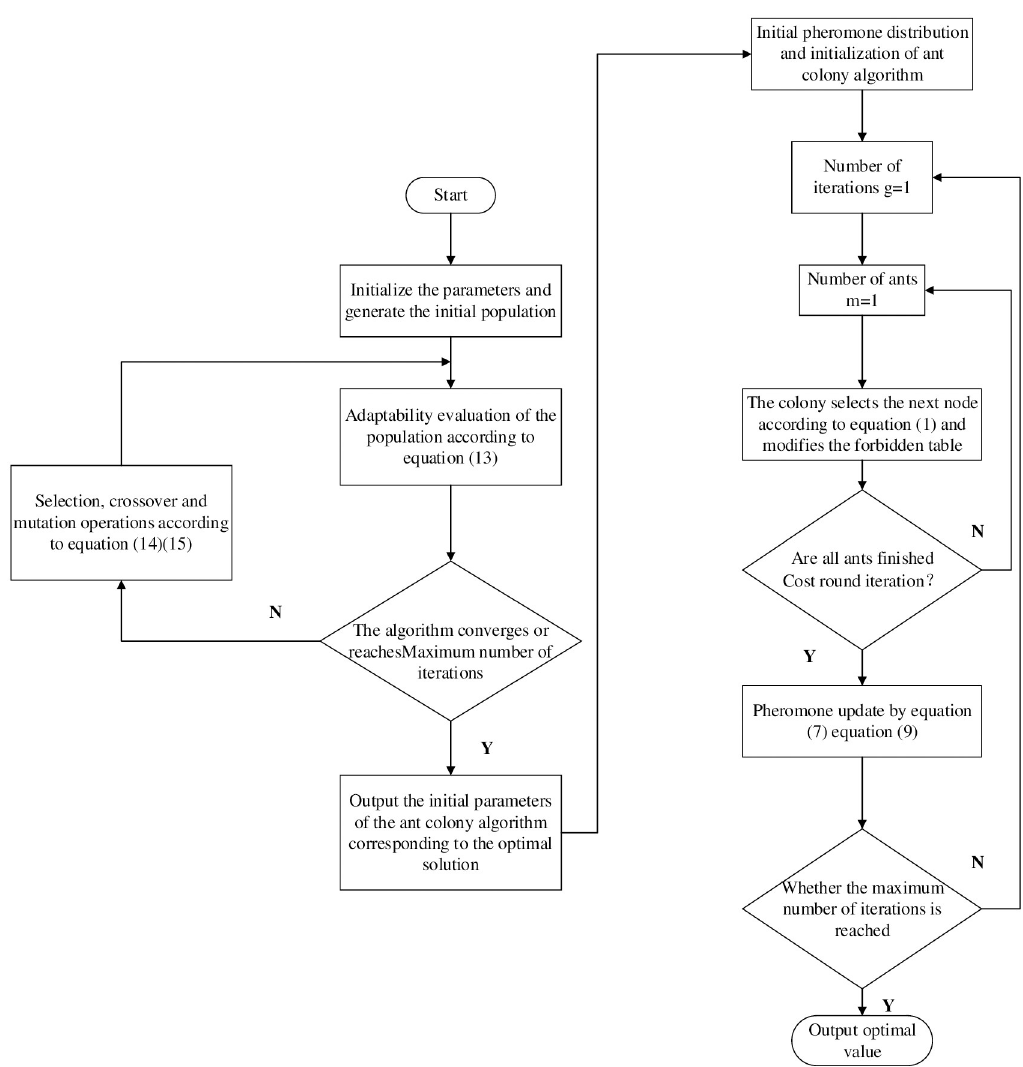
Fig 1. Optimal sequence ant colony algorithm implementation flow block